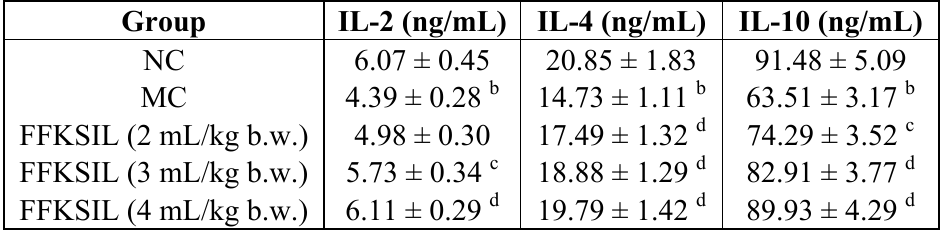
Table 2. Effect of FFKSIL treatment on serum IL-2, IL-4 and IL-10